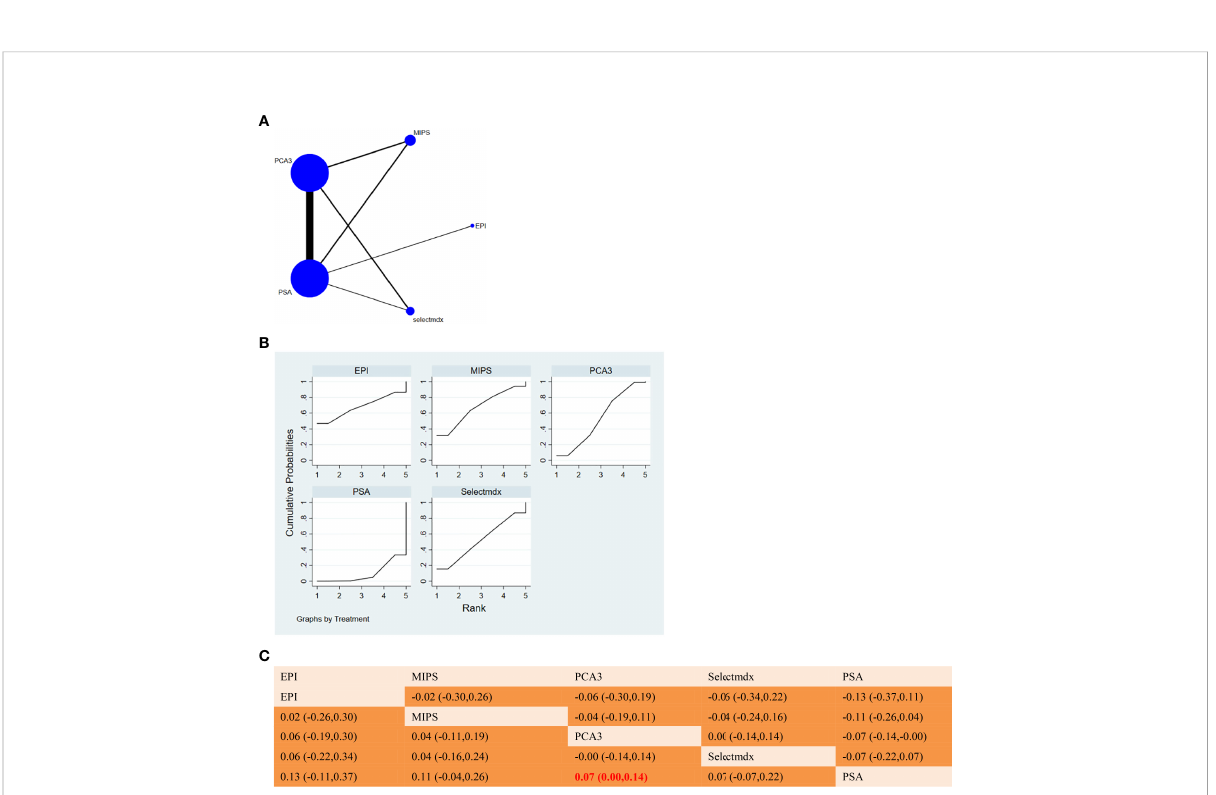
FIGURE 6 (A) NMA fi gure for NPV. (B) SUCRA plot for NPV. (C) League table on